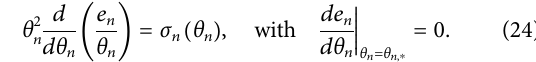
Frontiers in Cell and Developmental Biology |